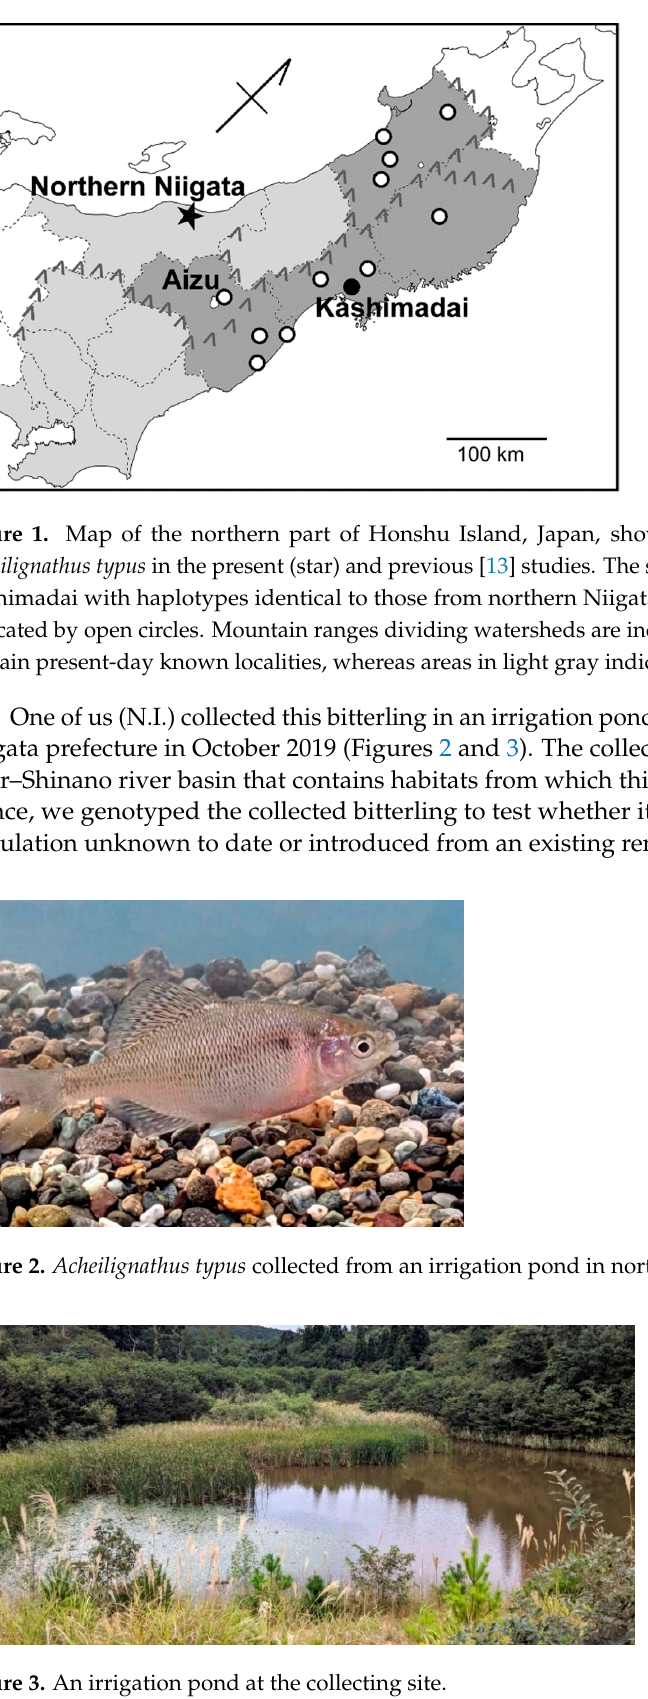
Figure 3. An irrigation pond at the collecting site.